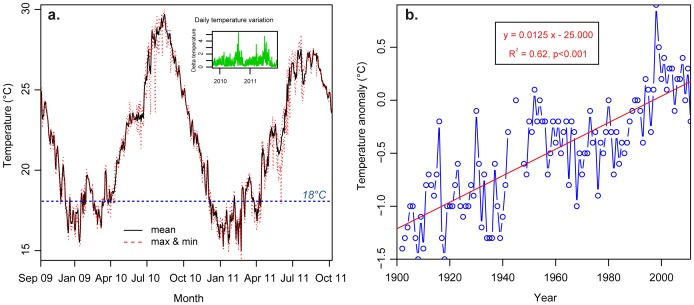
Seawater temperatures. a.Mean, maximum, and minimum seawater temperatures at the study site (at 5 m in depth) from November 2009 to October 2011. Inset represents daily temperature variations for the same period (data from [21], [25]). b. Long-term trend in sea surface temperature anomalies (deviation of mean annual temperature from mean temperature of the preceding three decades) from 1902 to 2011 in the northern part of the seas south of Japan. Red line corresponds to the linear regression analysis showing the +1.25°C increase occurring over the last century (data from [37]).